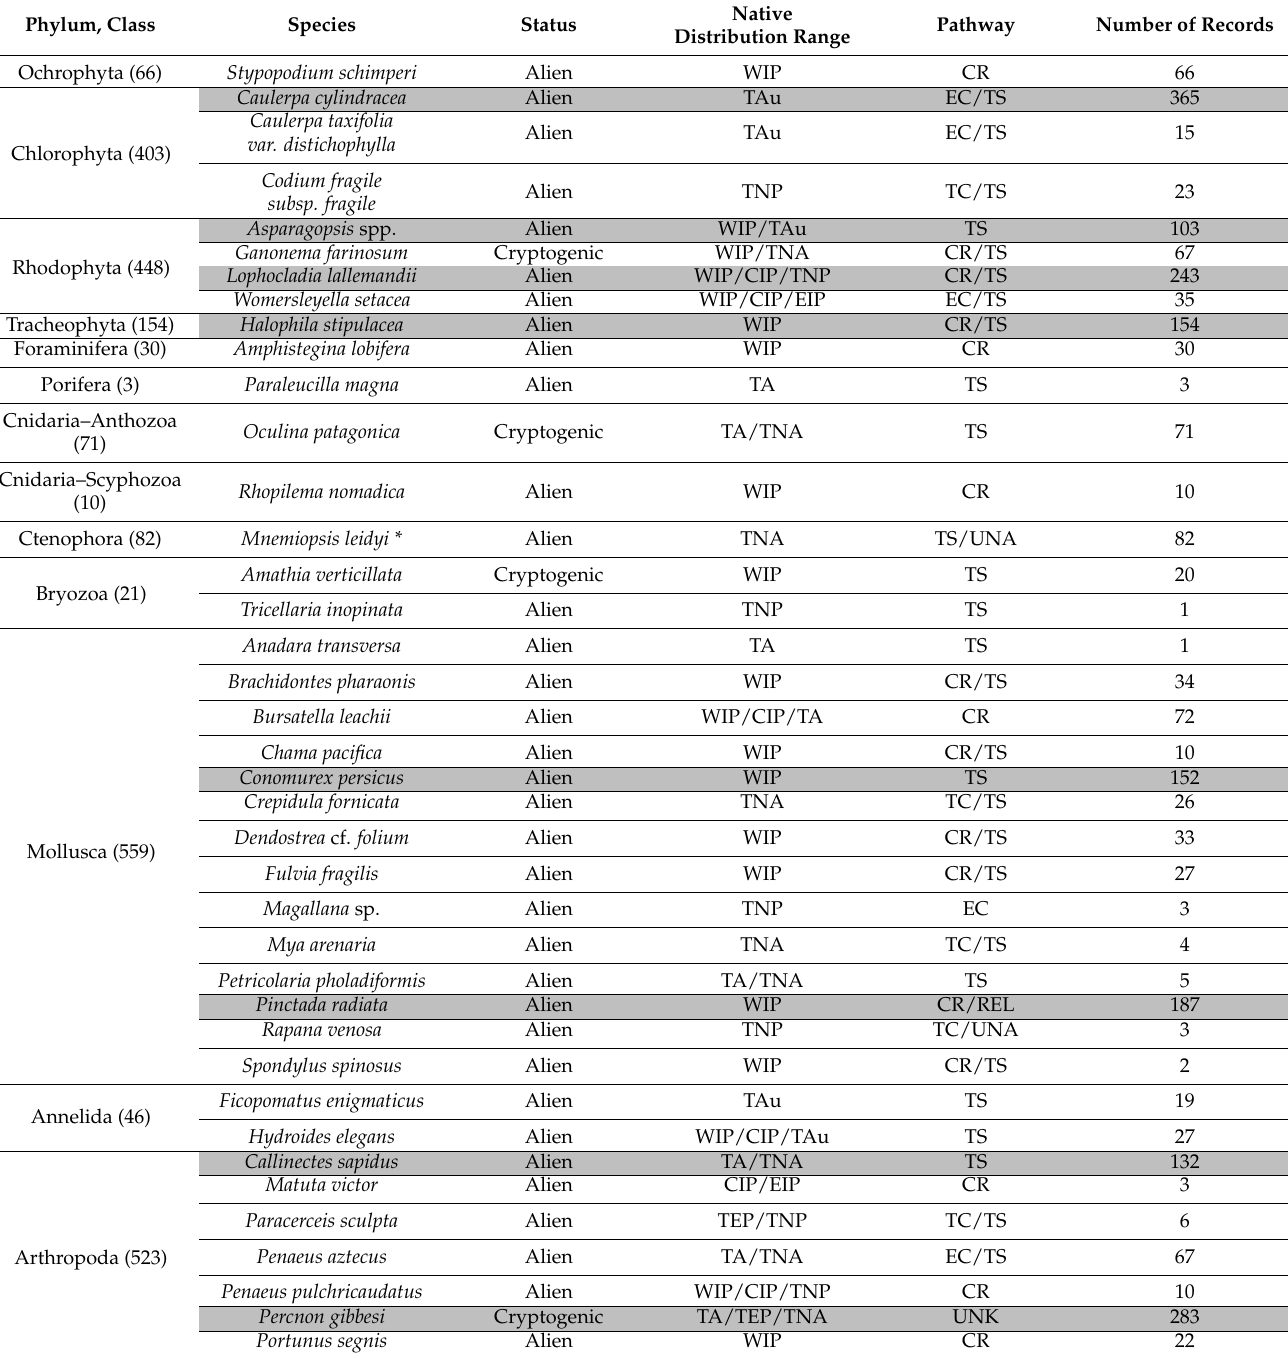
Table 1. Number of records of the investigated impactful cryptogenic and alien species (ICAS) per phylum, along with information on their biogeographic status (alien or cryptogenic); origin (i.e., native distribution range—WIP: Western Indo-Pacific, TA: Tropical Atlantic, Tau: Temperate Australasia, TNP: Temperate Northern Pacific, TNA: Temperate Northwest Atlantic, CIP: Central Indo-Pacific, TEP: Tropical Eastern Pacific, EIP: Eastern Indo-Pacific, UNK: Unknown); primary introduction pathway into the Mediterranean, if known (TS: Transport Stowaway, TC: Transport Contaminant, CR: Corridor, EC: Escape from Confinement, REL: Release into Nature, UNA: Unaided, UNK: Unknown) [54]. Numbers within parentheses indicate the total number of records per phylum. Grey highlights: most commonly recorded species (>100 records